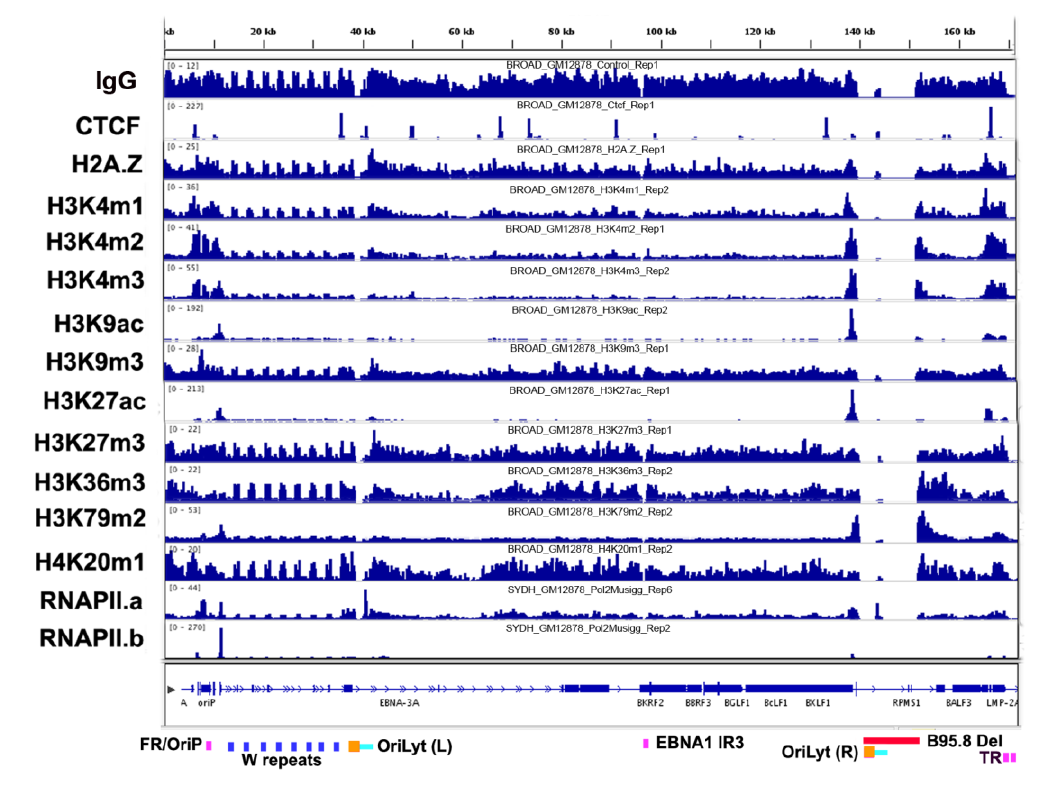
Figure 1. Chromatin overview of the Epstein-Barr virus (EBV) epigenome. ChIP-seq in lymphoblastoid cell lines (LCLs) are mapped to the wild-type HHV4 genome for